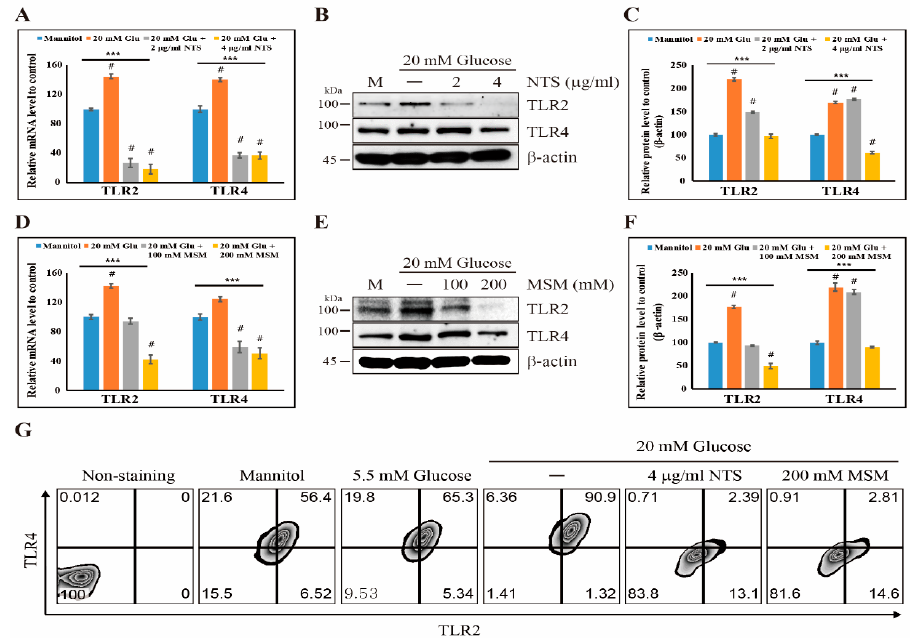
Figure 1. Sulfur compounds inhibit the expression of TLRs. ( A ) The expression levels of TLR2 and TLR4 mRNA in THP-1 cells were detected by real-time PCR after treatment with 20 mM glucose and NTS (2 and 4 μ g/mL) for 24 h and normalized to GAPDH mRNA. The values are presented as means ± SEM of three independent experiments performed in duplicate ( n = 3). *** p < 0.001 ( ANOVA test). #The mean difference is significant at the 0.001 level. ( B ) Western blot analysis of THP-1 cells treated with 2 and 4 μ g/mL NTS for 24 h showing the inhibition of high glucose-induced TLR2 and TLR4 expression. ( C ) The representative expression levels of proteins following NTS treatment were determined by densitometry and normalized to β -actin. The values are presented as means ± SEM of three independent experiments performed in duplicate ( n = 3). *** p < 0.001 ( ANOVA test). #The mean difference is significant at the 0.001 level. ( D ) Real-time PCR data of mRNA after treatment with 20 mM glucose and MSM (100 and 200 mM) for 24 h showing the relative expression levels of TLR2 and TLR4 normalized to GAPDH mRNA. The values are presented as means ± SEM of three independent